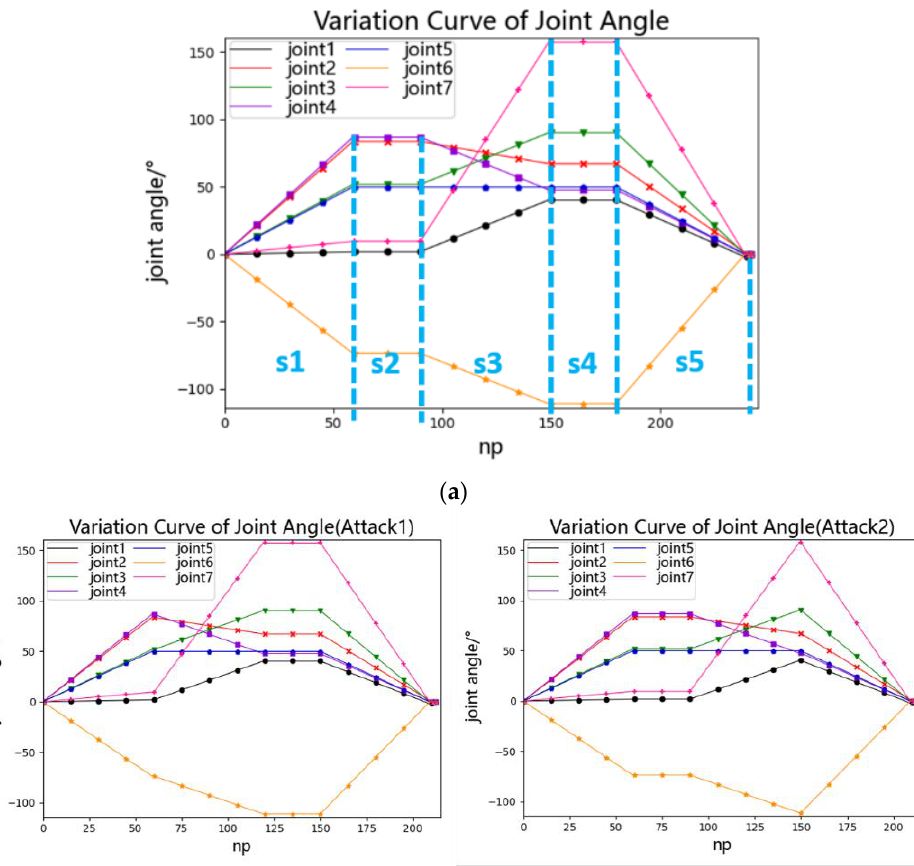
Figure 6. ( a ) Joint angle data under normal condition. ( b ) Joint angle data under PPL attack.